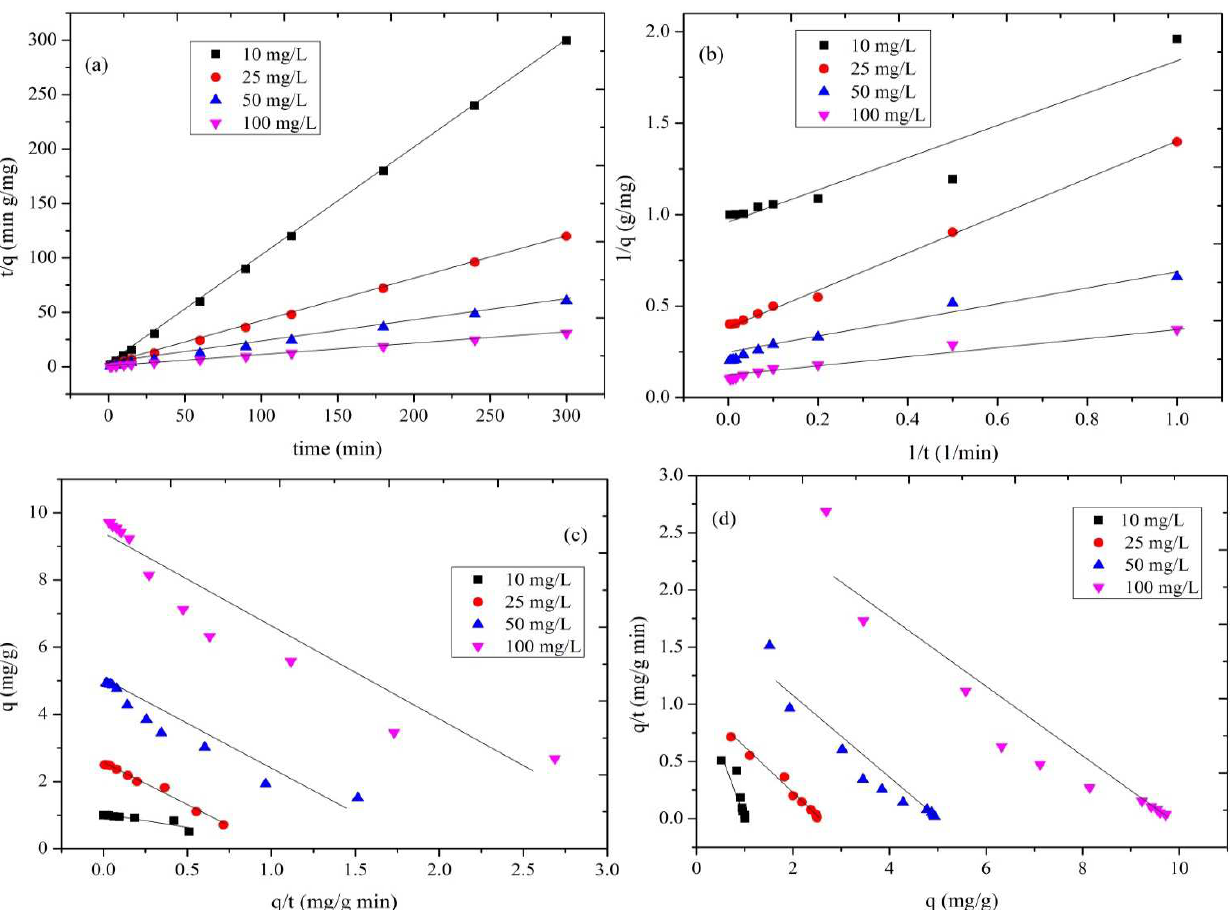
Figure 5. Linear plot of pseudo second-order kinetic model of methylene blue (MB) onto acid- activated spent tea (AAST) surfaces (a: form 1, b: form 2, c: form 3, and d: form